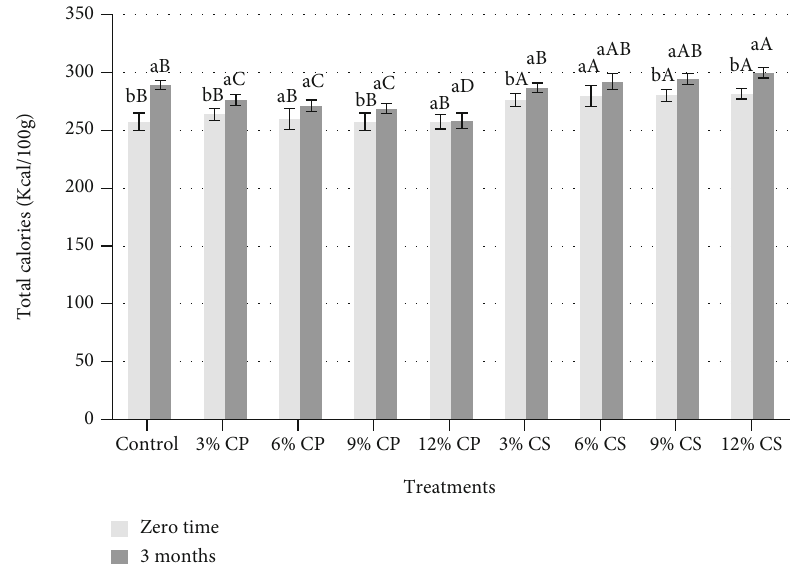
Figure 1: Changes in total calories of cooked chicken patties supplemented with cantaloupe peel (CP) and seeds (CS) powder during storage at -20 for 3